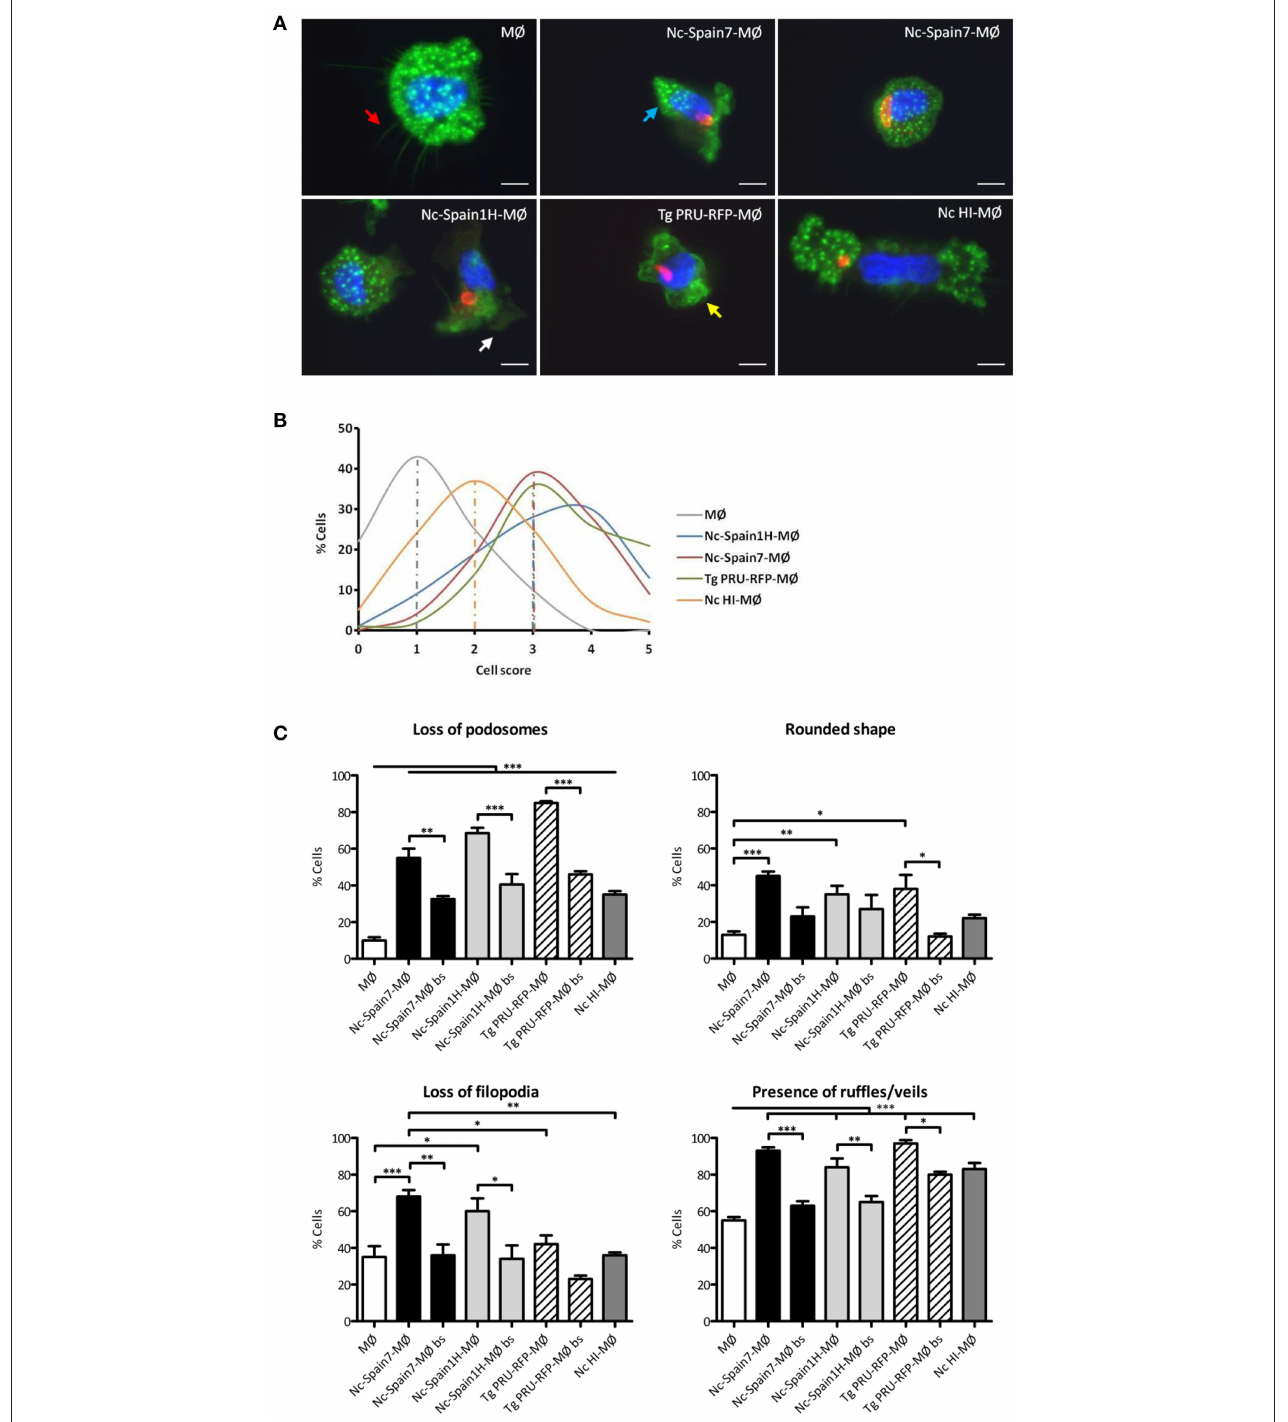
FIGURE 3 | Morphological changes in bovine MØs induced by N. caninum and T. gondii active invasion. (A) Representative micrographs of non-infected MØs (MØ) and MØs challenged for 8h with N. caninum Nc-Spain7 (Nc-Spain7-MØ), Nc-Spain1H (Nc-Spain1H-MØ), heat-inactivated tachyzoites (Nc HI-MØ), or T. gondii PRU-RFP (Tg PRU-RFP-MØ). F-actin is presented in green, nuclei in blue and parasites in red. Cell structures studied are pointed with arrows: podosomes (blue), filopodia-like extensions (red), ruffles (yellow), and veils (white). Scale bar is 10 µ m. (B) The distribution of the total scores obtained are presented as the percentage relative to the total population of MØs, Nc-Spain7-MØs, Nc-Spain1H-MØs, Tg PRU-RFP-MØs, and Nc HI-MØs. Cells were graded according to the following morphological criteria: ( i ) Podosome structures: present (score 0) vs. reduced (score 1) or absent (score 2); ( ii ) Cell shape: elongated (score 0) vs. rounded